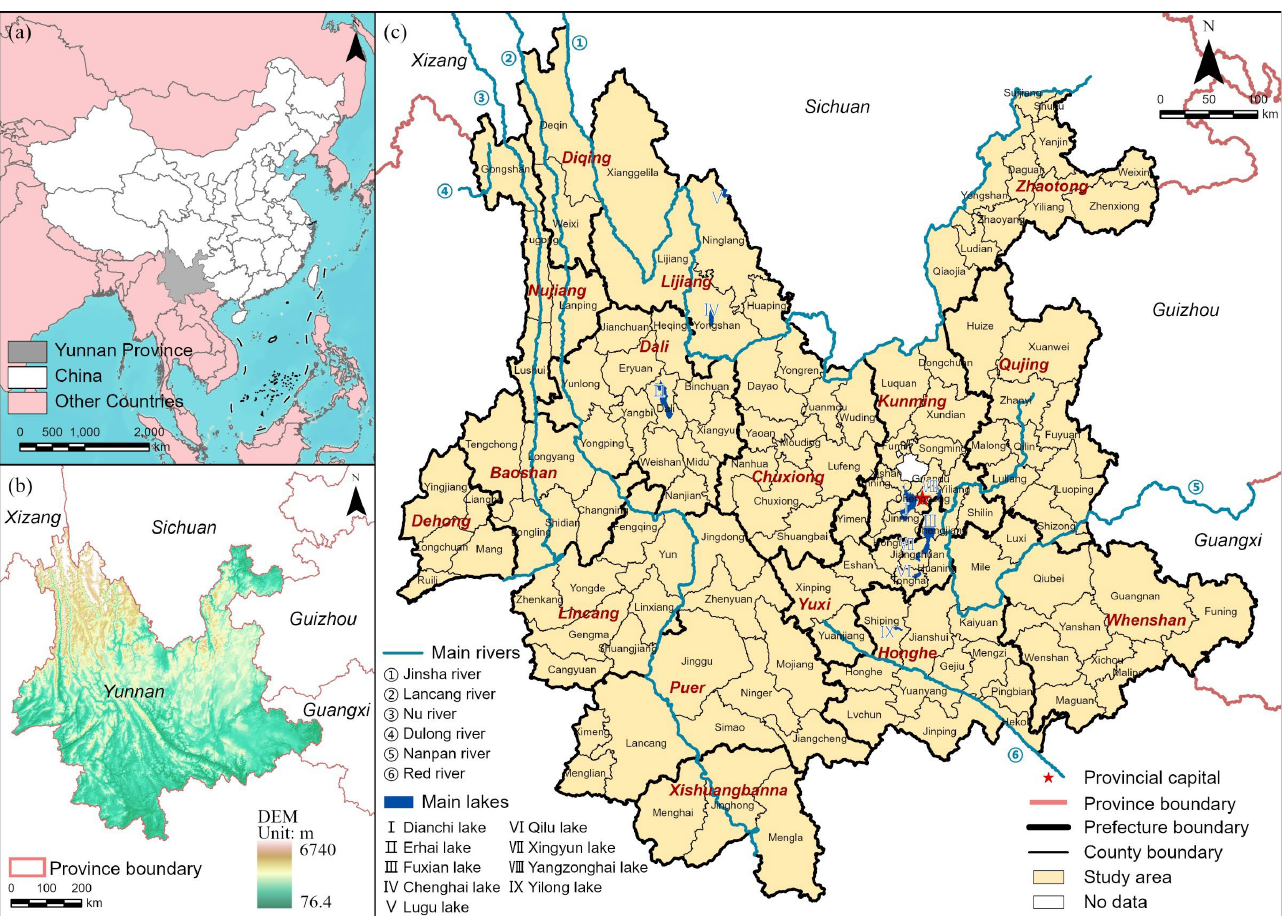
Figure 1. ( a ) The location of study area, ( b ) DEM, and ( c ) study